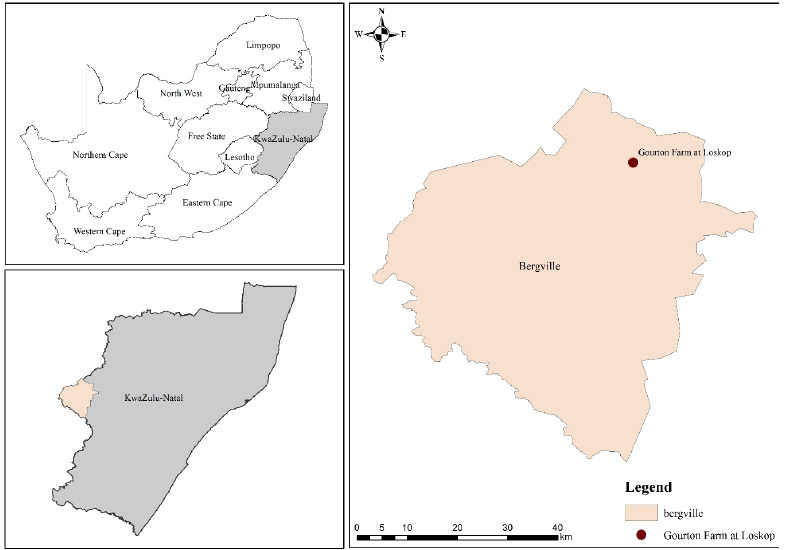
Figure 1. The experimental site, shaded with grey on the map, at Loskop in Estcourt, KwaZulu Natal Province, South Africa. The field trial was arranged as a randomized split plot design, with tillage forming the main plot (1 m × 4 m) and fertilizer application rate being the sub-plot (1 m × 1 m). In each tillage urea fertilizer was applied at four application rates of 0, 60, 120, and 240 kg N ha −1 . NT was characterized by no soil disturbance (no ploughing), while a sod seeder was utilized for planting. CT-Y5 comprised of leaving the soil unploughed for four seasons, then tilling every 5th season. Soil sampling in CT-Y5 was done in the 5th season (five years after the last tillage). In CT-ANNUAL there was annual disturbance of soil by tilling using a tractor to a depth of 30 cm. Soil was sampled after harvest to avoid plant disturbance at three depths of 0–10, 10–20, and 20–30 cm. Each tillage treatment had three blocks that were sampled making nine blocks in total, with each block having four N fertilizer appli- cation rates which were all replicated three times.